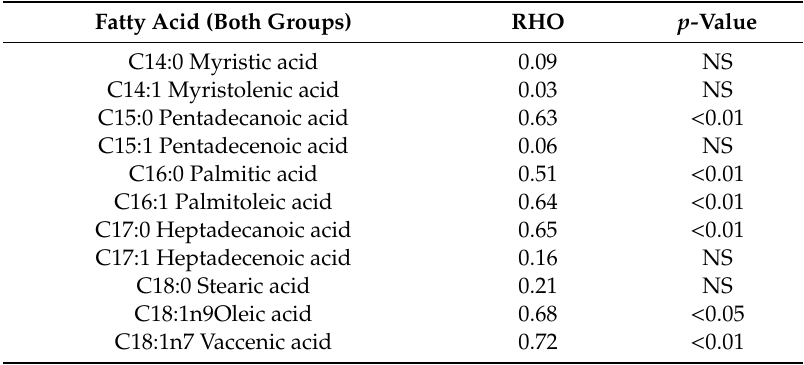
Table 4. Correlation of fatty acids between liver and blood among all groups. Fatty Acid (Both Groups)